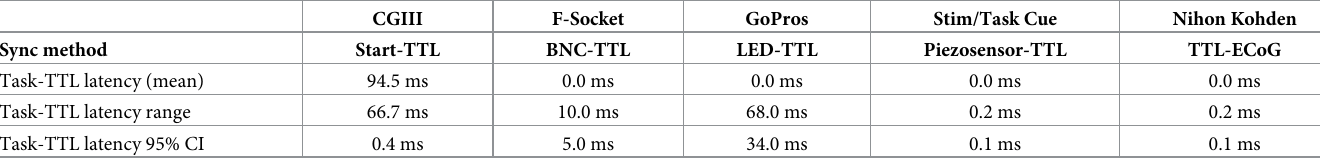
Table 1. Synchronization method with their mean, range, and 95% confidence interval for each data stream.